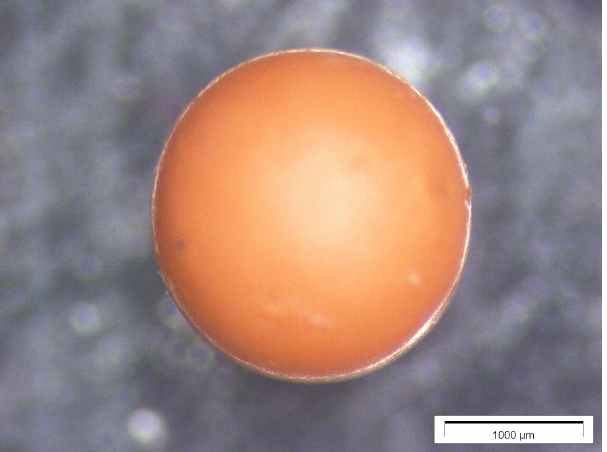
Figure 2. Microscopic image of a 10 µ L RF-Aerogel droplet after drying under ambient